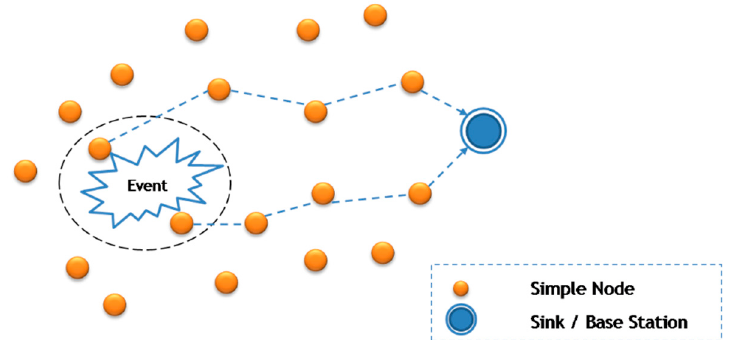
Figure 2. Event-driven routing model.